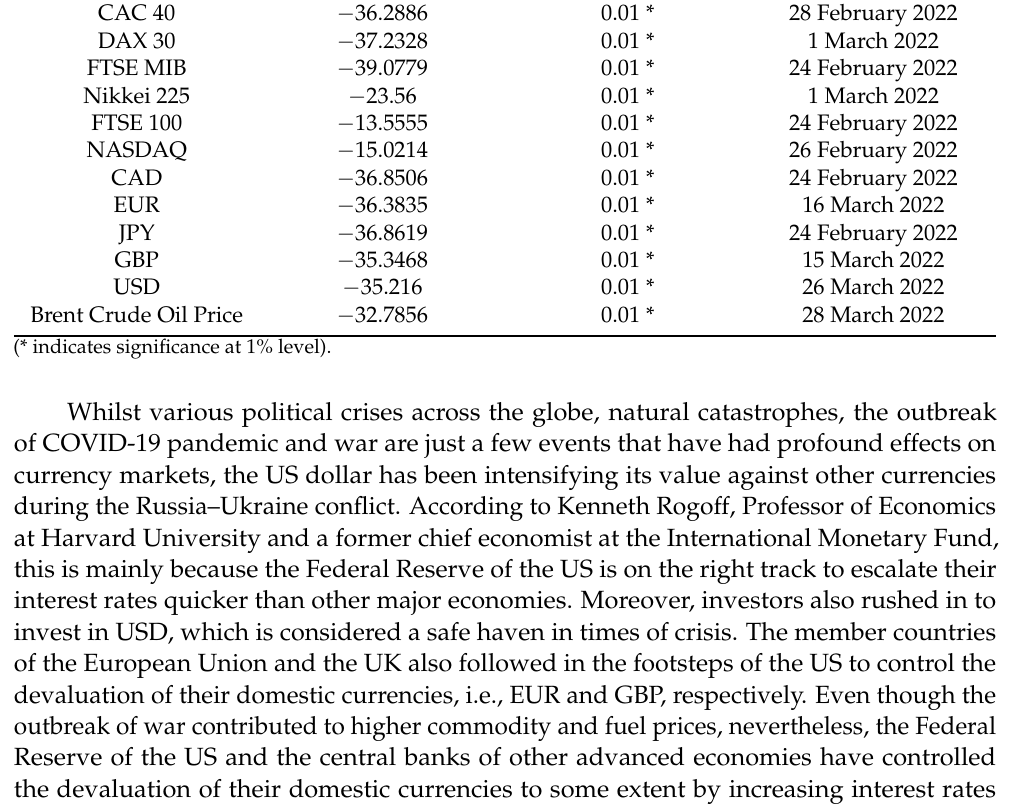
Table 3. Break-point Unit root test of Stock Market Indices, Currency Exchange Rates and Brent Crude Oil Price. Trend and Intercept (Innovative Outlier Model) At Level Variables t-Statistics p -Value Break